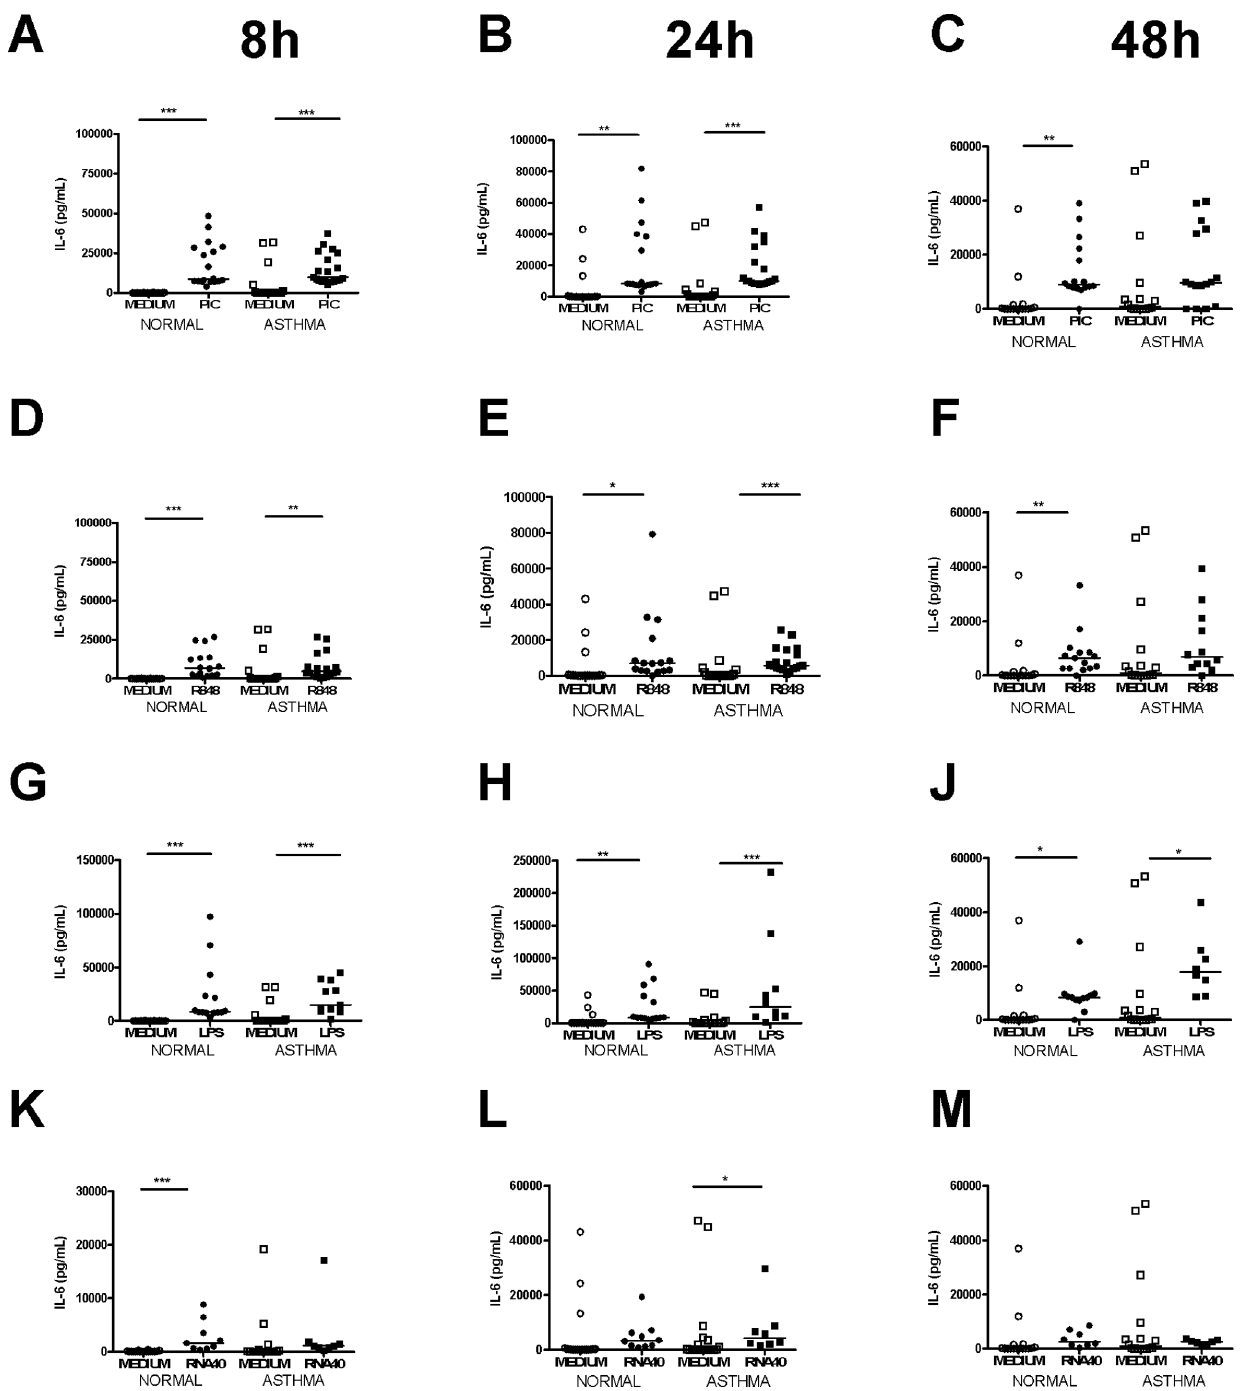
Figure 6. IL-6 induction following TLR stimulation in PBMCs. Graphs depict IL-6 production at 8 h following stimulation with PIC [A], R848 [D], LPS [G] and LPS [K], 24 h following PIC [B], R848 [E], LPS [H] and LPS [L] and 48 h following PIC [C], R848 [F], LPS [J] and LPS [M]. Squares represent asthmatics, circles represent non-asthmatics. *=p , 0.05, **=p , 0.01, ***=p , 0.001.